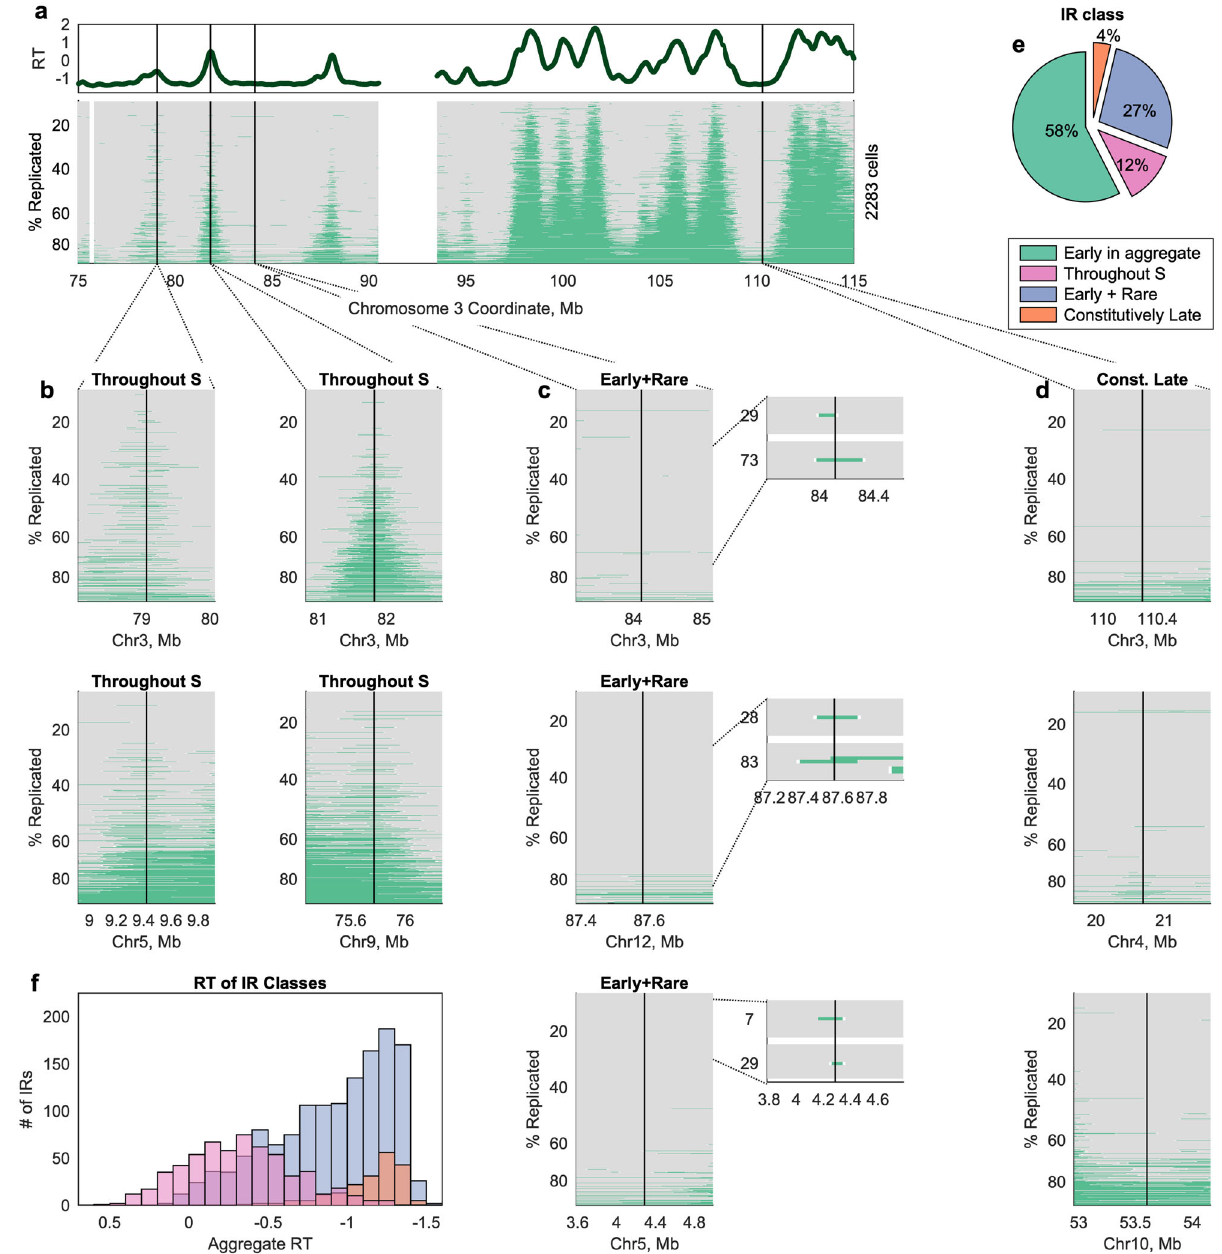
Fig. 5 Three distinct classes of IRs with late aggregate replication timing. a – d Ensemble late IRs can be classi fi ed into three classes based on their behavior across single cells: some fi re throughout S phase ( b ), some fi re rarely but often fi re early when they do fi re ( c ), and some were never observed to fi re early ( d ). The IRs indicated with black lines in a are shown in the top row of b , c , and d . Additional examples are shown below. e About 27% of IRs with late aggregate replication timing fi re infrequently but with a preference for early S phase, while 12% fi re throughout S phase. Constitutive late fi ring is rare (4% of IRs). f IRs that fi re throughout S phase (pink) tend to have earlier replication timing than the other two classes of IRs, while those that were constitutively late (orange) had the latest average replication Single-cell replication timing across cell lines throughout S phase . Having established a work fl ow for high-throughput replication analysis of unsorted cells, we performed whole- genome sequencing of 9658 single cells across eight additional cell lines: two LCLs, three embryonic stem cell lines (ESCs), and three cancer cell lines. As with GM12878, we performed in silico cell sorting to distinguish replicating and nonreplicating cells within each library (Supplementary Fig. 6a). For each cell line, we gen- erated an aggregate S/G 1 pro fi le that was highly correlated to an S/G 1 bulk replication-timing pro fi le for the same cell line